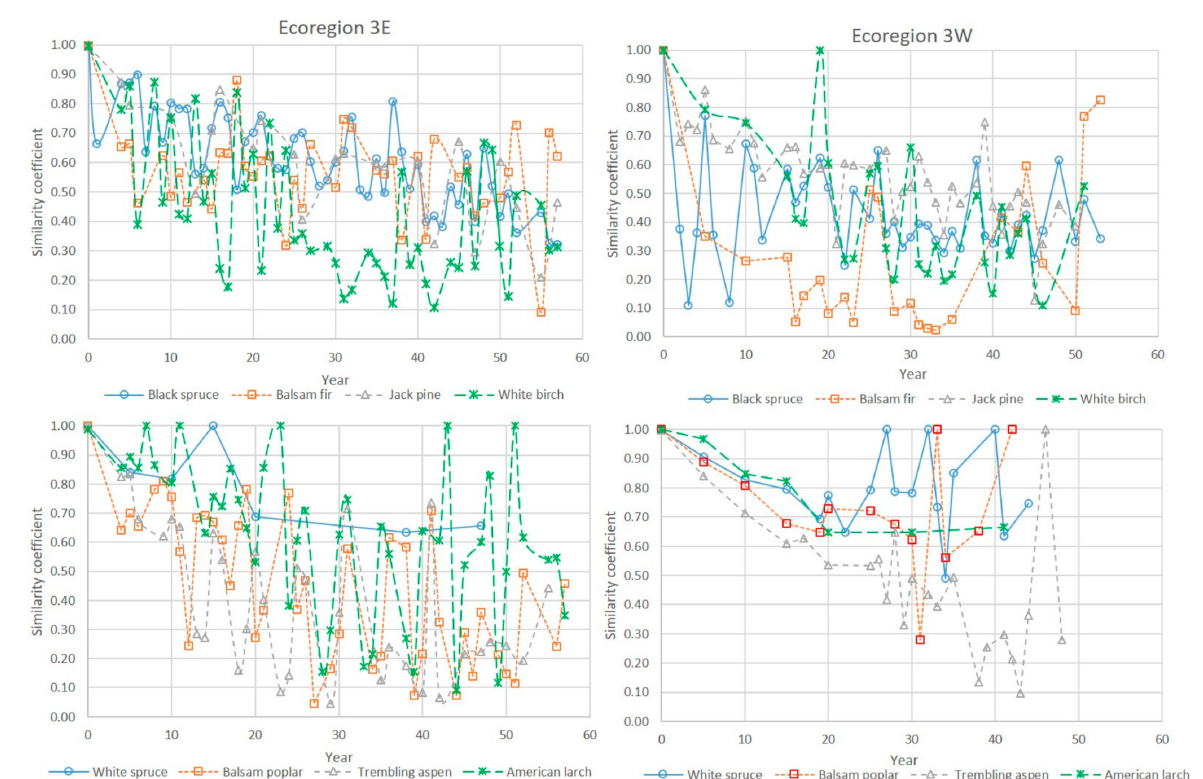
Figure 7. Similarity coefficients derived for comparing observed and predicted diameter distributions for different tree species over years in two ecoregions of the boreal forest region of northern Ontario,